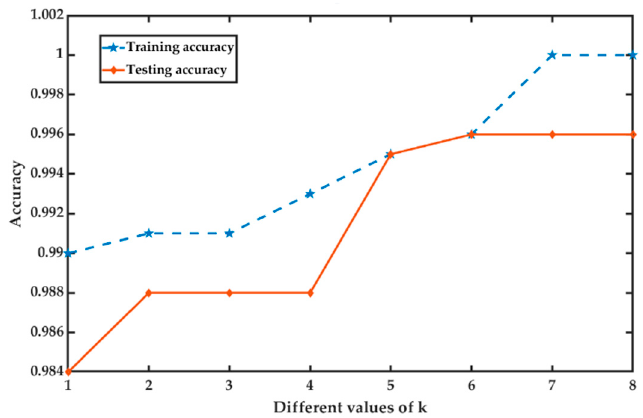
Figure 14. Determining the optimal value of k Figure 14 . Determining the optimal value of k . Figure 14 . Determining the optimal value of k .